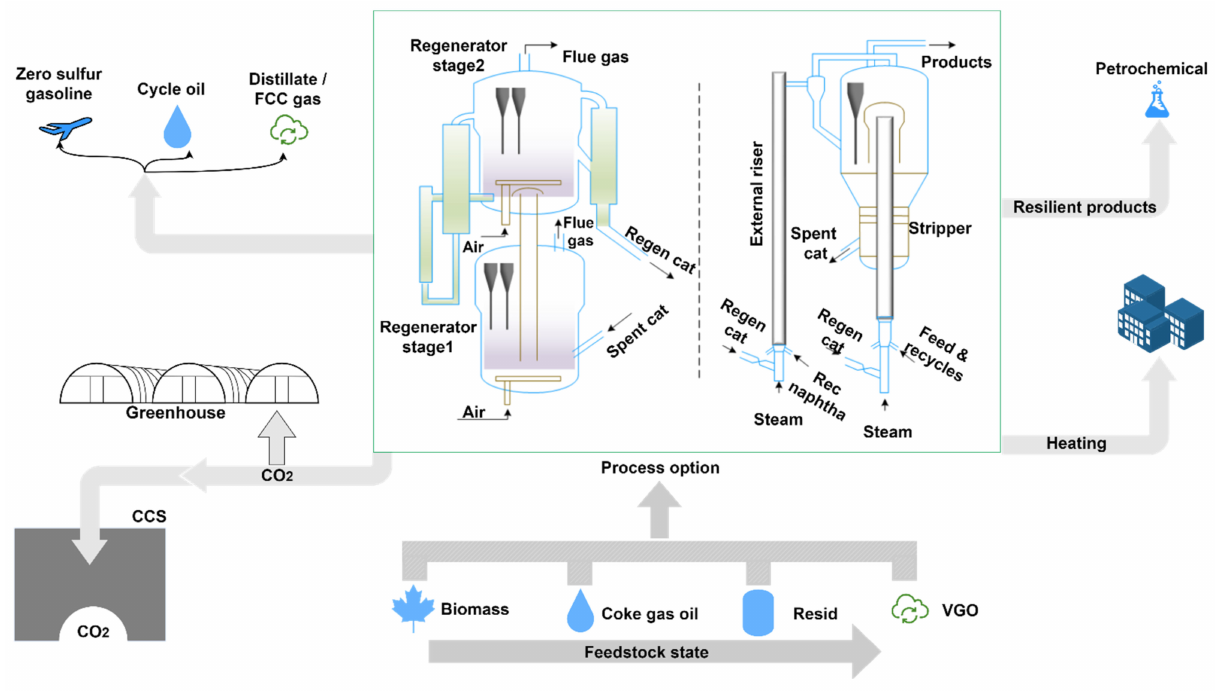
Figure 2. Illustration of future roles of FCC unit. Note: CCS: carbon capture and storage, VGO: vacuum gas oil, Rec: reactant